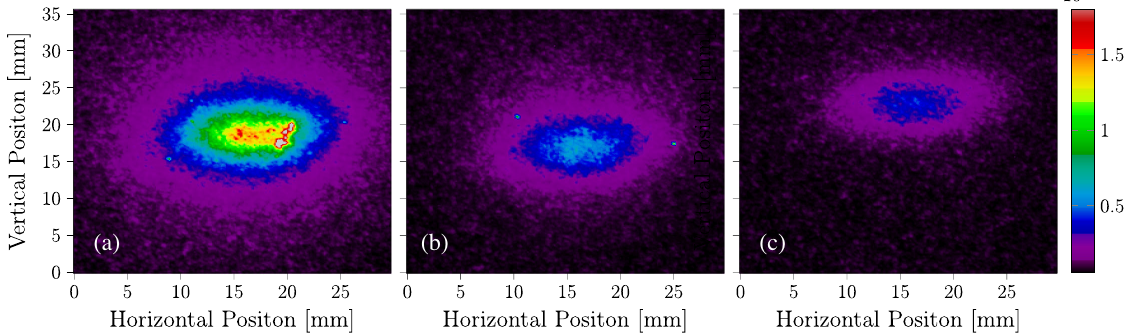
FIG. 6. Transverse profile for aluminum (a), steel (b), and glassy carbon (c) targets for same beam conditions corresponding to ψ ¼ 50 ° for 5 × 10 9 Ca 10 þ ions per macropulse. The plot is an average of 250 macropulses in stable low intensity machine conditions.